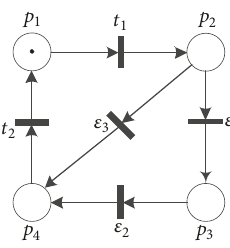
Figure 1: A Petri net system.